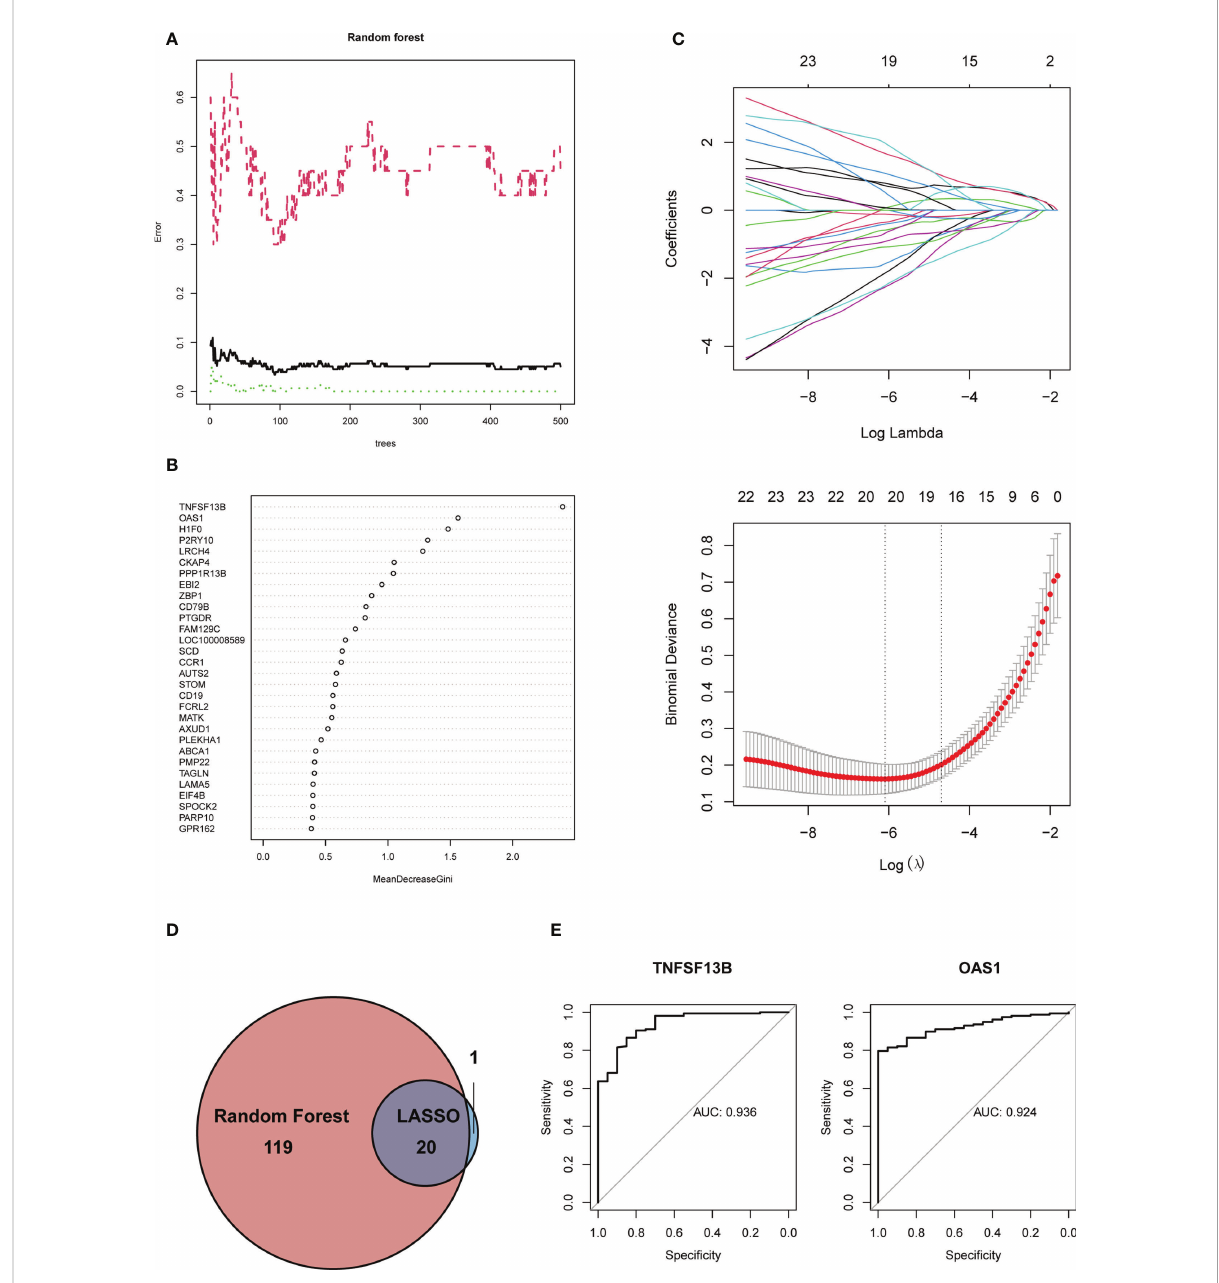
FIGURE 5 (A) Gene selection via Random Forest algorithm. (B) The top 30 signi fi cant genes recognized from Random Forest. MeanDecreaseGini showed the rank of genes in accordance with their relative importance. (C) The performance in of ten-time cross-veri fi cation for tuning parameter in selection least absolute shrinkage and selection operator (LASSO). Each coef fi cient curve in the upper picture represents a single gene. The solid vertical lines in another picture represent the partial likelihood deviance SE, and the number of genes (n = 20) corresponding to the lowest point of the curve is the most suitable for LASSO. (D) The intersected genes of these two algorithms were selected. (E) ROC curves of TNFSF13B (AUC = 0.936, 95%CI 0.885-0.986) and OAS1 (AUC = 0.924, 95%CI